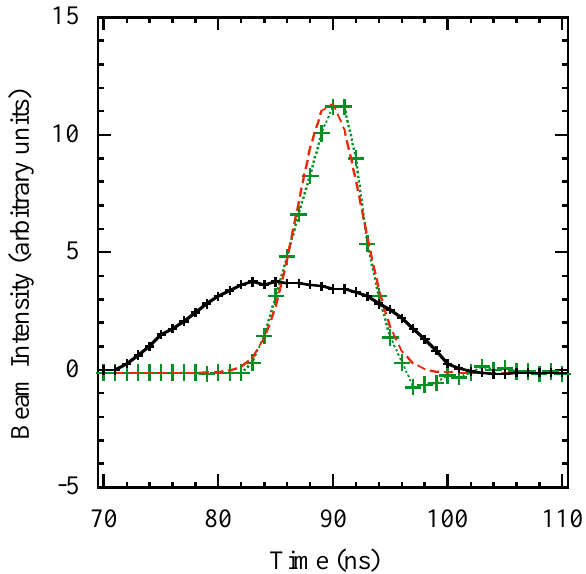
FIG. 8. (Color) Bunch shapes before and after bunch- ing (crosses) showing a final corrected bunch length of s (cid:173) (cid:50)(cid:46)(cid:54)(cid:54) ns for a (cid:49)(cid:46)(cid:53) V s bunch together with the fitted Gaussian curve (dashed line).